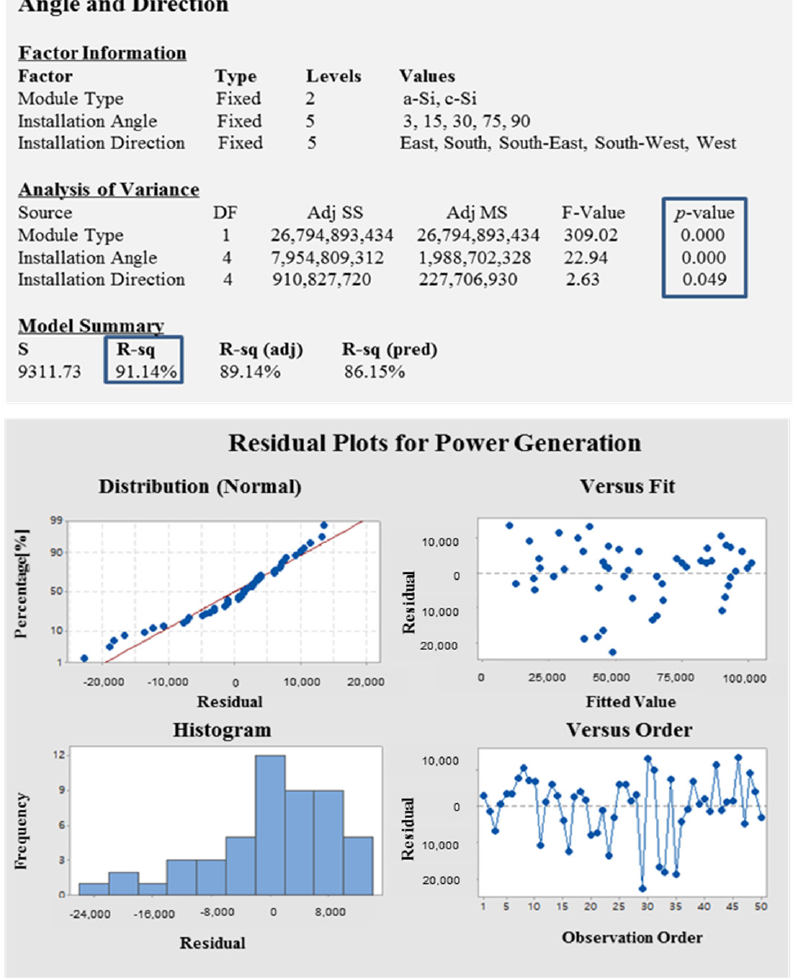
Figure 8. ANOVA of power generation for different module types, installation directions, and angles.